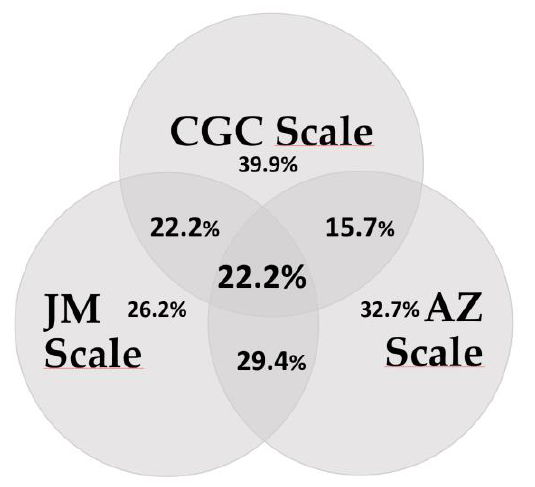
Figure 1. Venn diagram with coincidence percentages among scales.